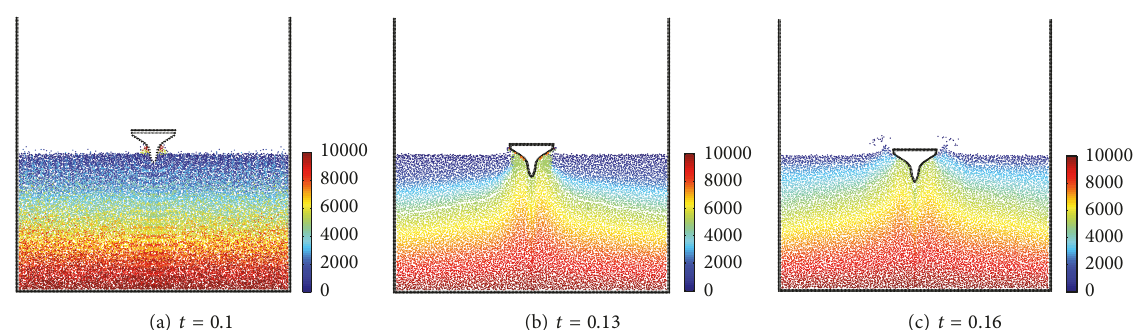
Figure 6: Particles colored by pressure after the impact with entry angle 0 with velocity